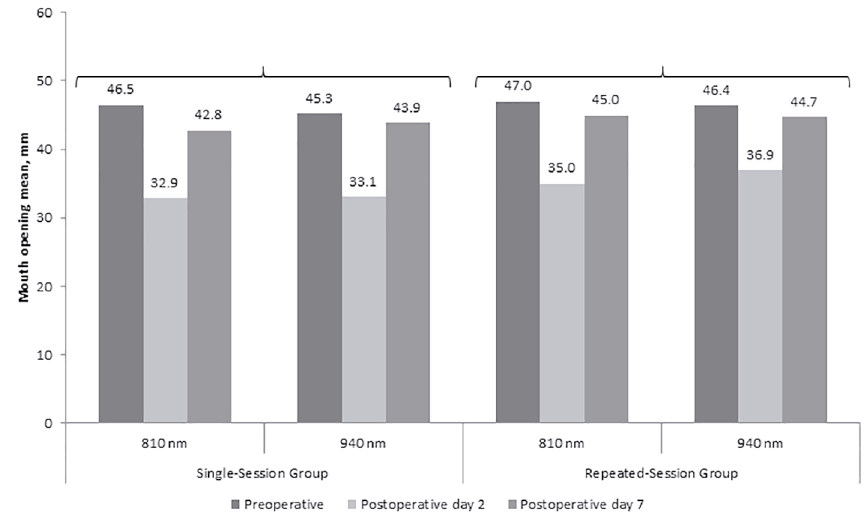
Figure 4- Comparisons of the 810 nm and 940 nm groups in terms of mouth opening in single-session and repeated session laser groups